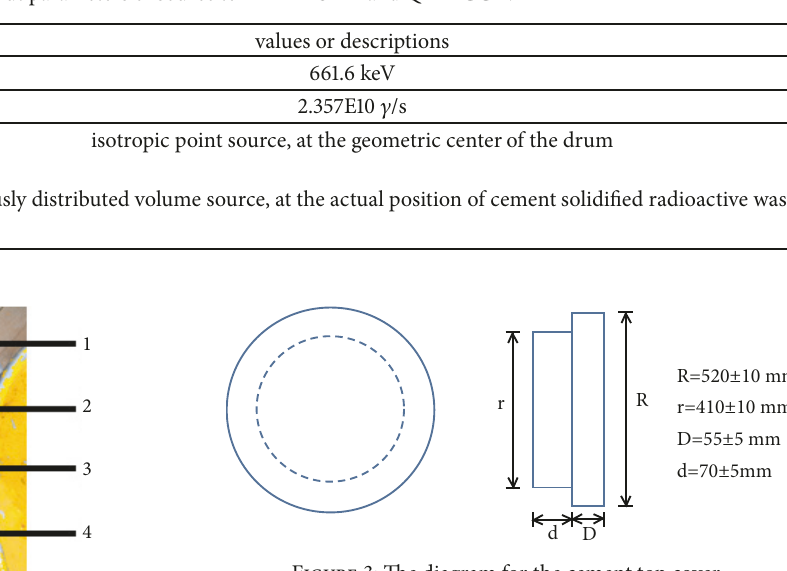
Figure 3: The diagram for the cement top